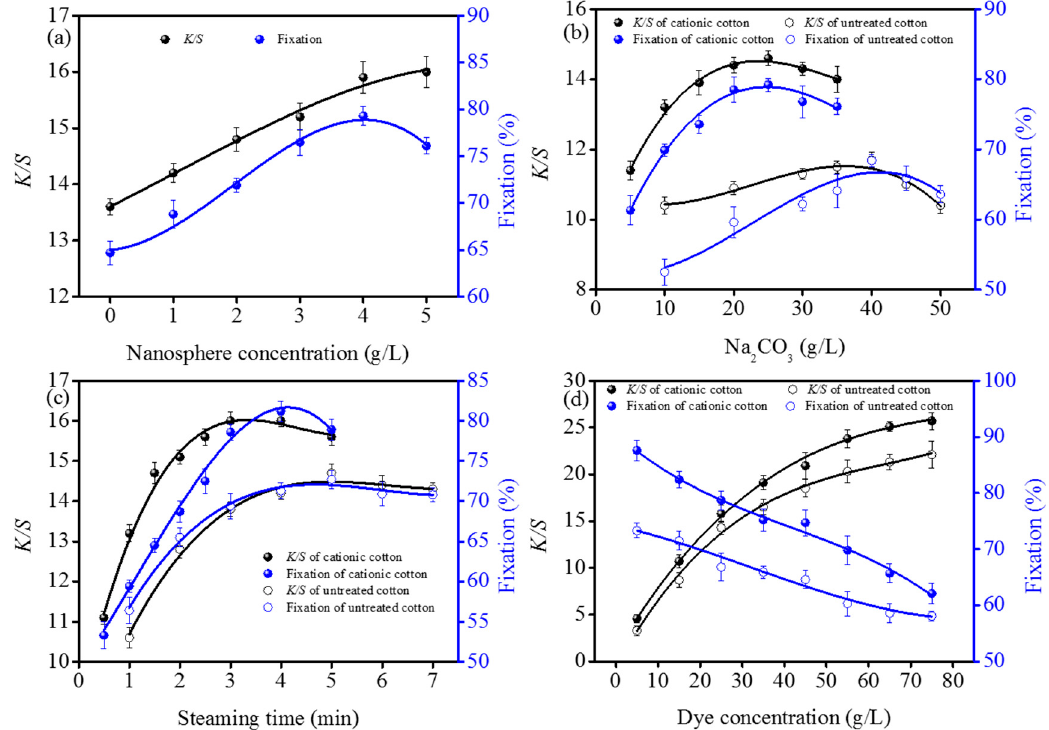
Figure 2. Effect of cationic nanosphere concentrations: ( a ) Na 2 CO 3 amounts, ( b ) steaming time, ( c ) and dye concentration ( d ) on the K / S values and dye fixation rates of dyed cotton fabrics. All the pickup of fabrics were (70 ± 1)% and steaming temperature was (102 ± 1) °C.